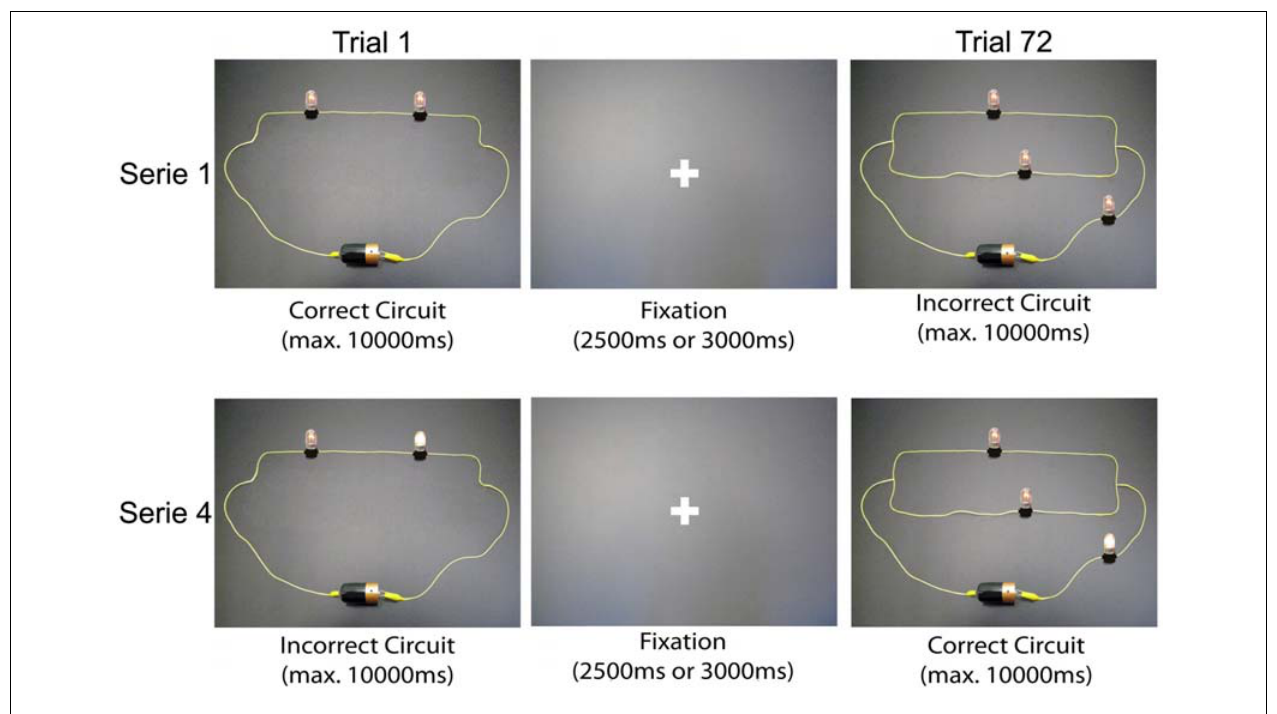
FIGURE 2 | Excerpts of the fMRI task, composed of 288 electric circuit